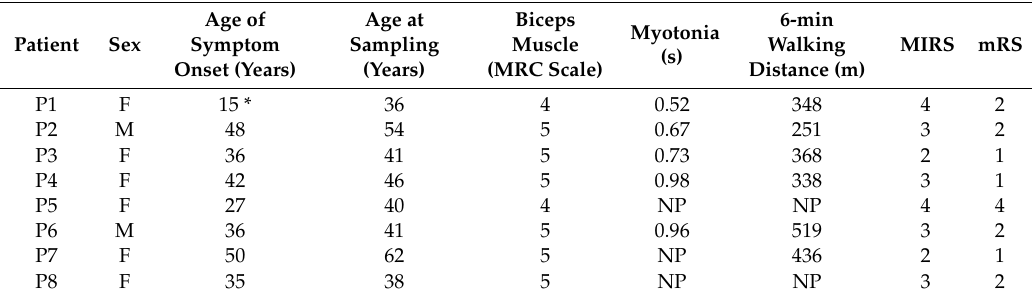
Table 1. Clinical characteristics of the